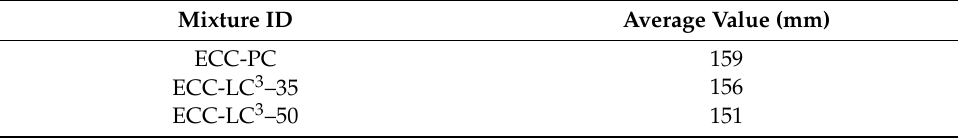
Table 6. Flowability Table 6.